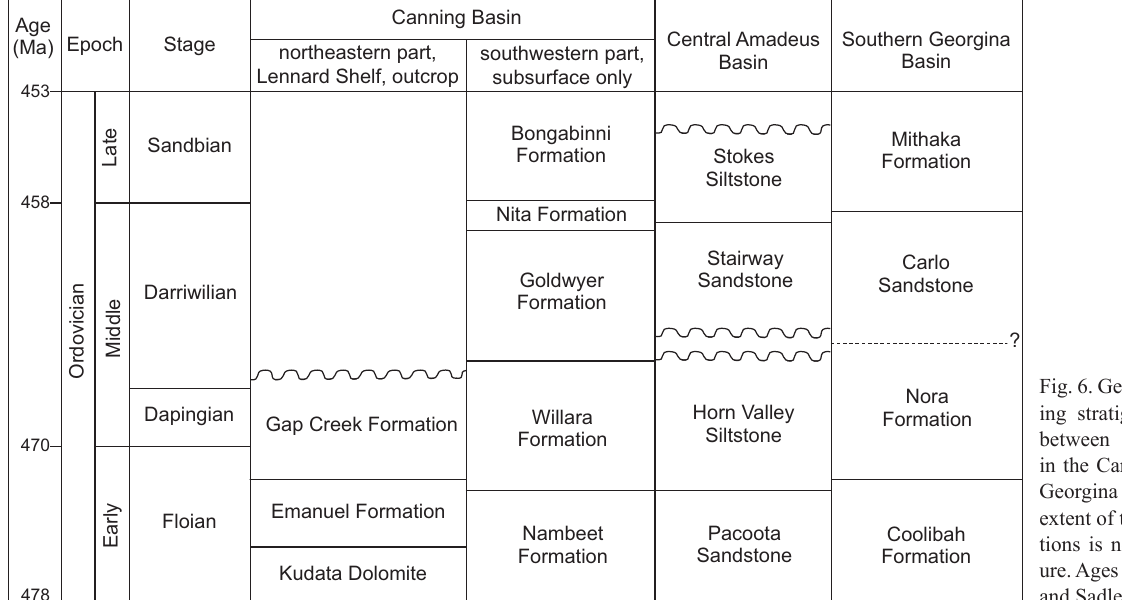
Fig. 6. Generalized chart show- ing stratigraphic relationships between selected formations in the Canning, Amadeus, and Georgina basins. The entire extent of the lowermost forma- tions is not shown on the fig- ure. Ages adopted from Cooper and Sadler